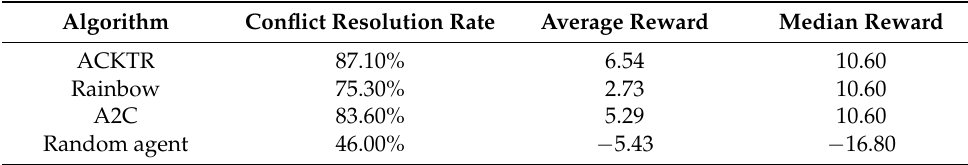
Table 7. Performance of different algorithms on 1000 test samples.